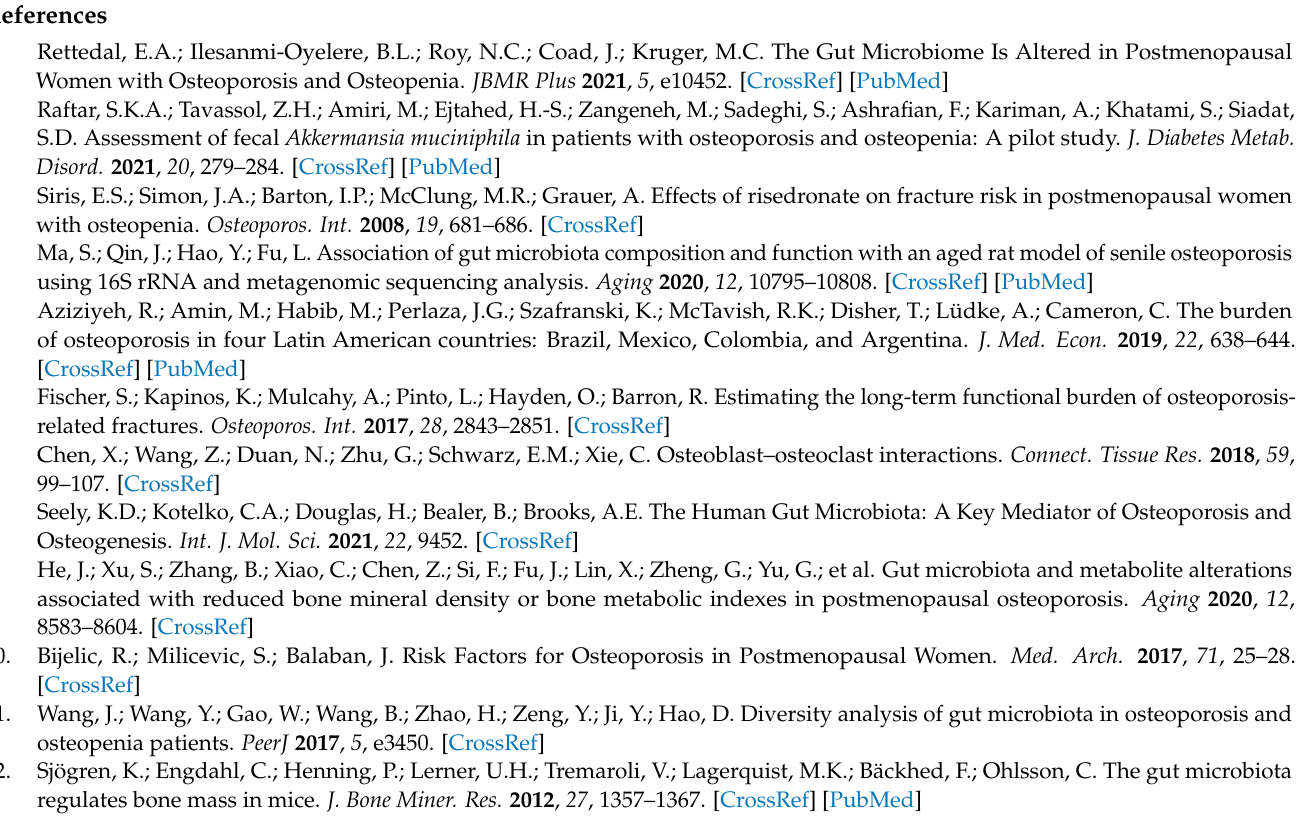
participants; Figure S1: Comparison of rarefaction (A) at lowest sequence depth among the